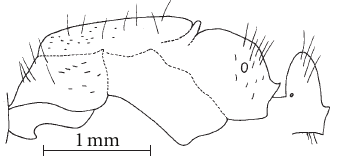
Figure 3: Posterior left tibia of a minor worker of C. reburrus (Napo, Ecuador).